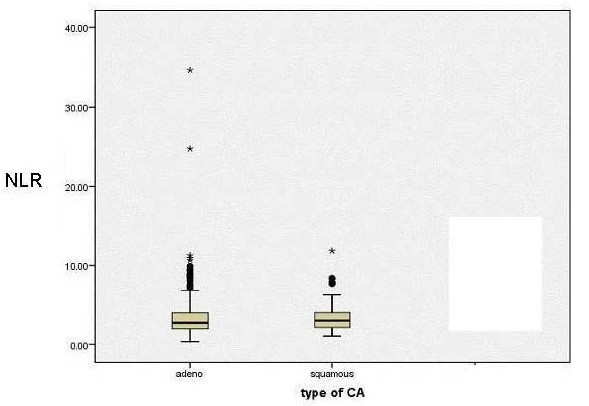
NLR median and IQR box plot for three oesophageal cancer groups.